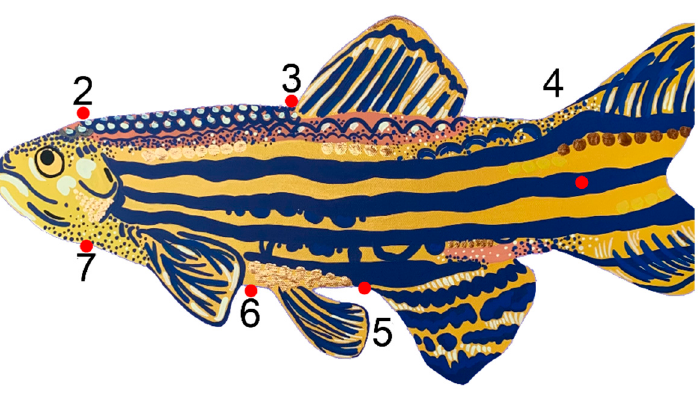
Figure 1. A total of seven digitized landmarks were placed on distinct points of zebrafish for use in the morphometric analysis. Landmarks denote: (1) mouth, (2) posterior dorsal skull, (3) anterior dorsal fin, (4) caudal fin, (5) anterior anal fin, (6) ventral surface, and (7) ventral anterior skull. Art created by Gillian McHaney.